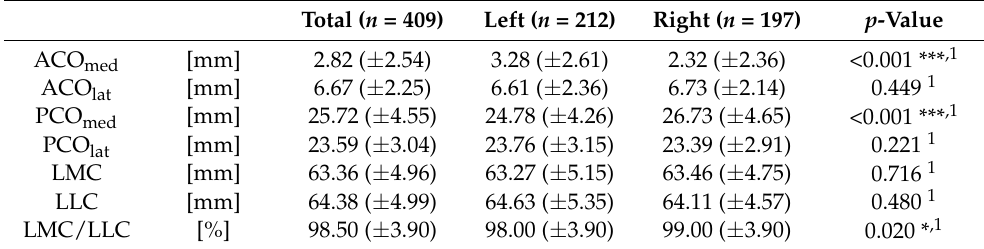
Table 3. Analysis of side-specific differences for femoral condylar parameters in patients with radiologically healthy knee joints ( n = 409).